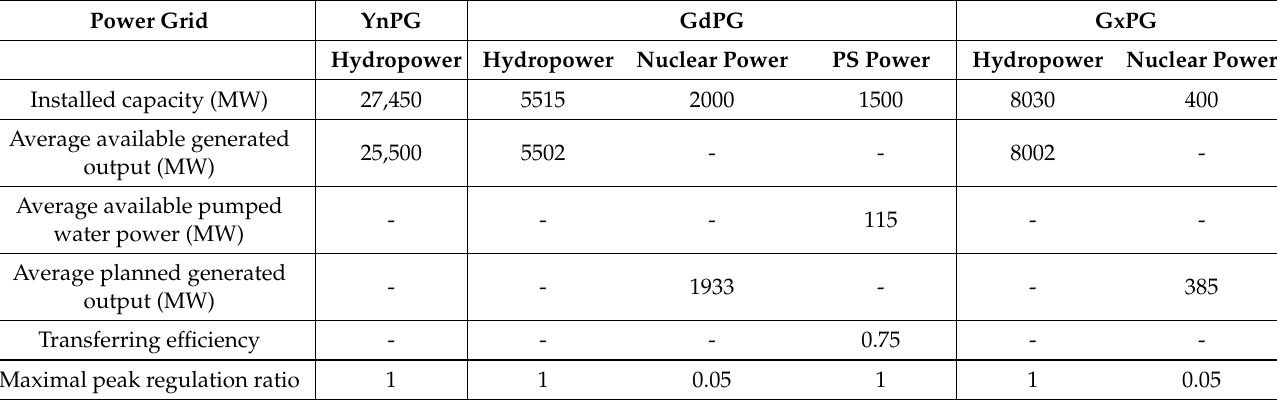
Figure 3. ( a ) Diurnal load of three power grid components and ( b ) generated output of wind and Figure 3. (a) Diurnal load of three power grid components and (b) generated output of wind and solar power. solar power. Table 1. Configuration information of power plants in each power gird